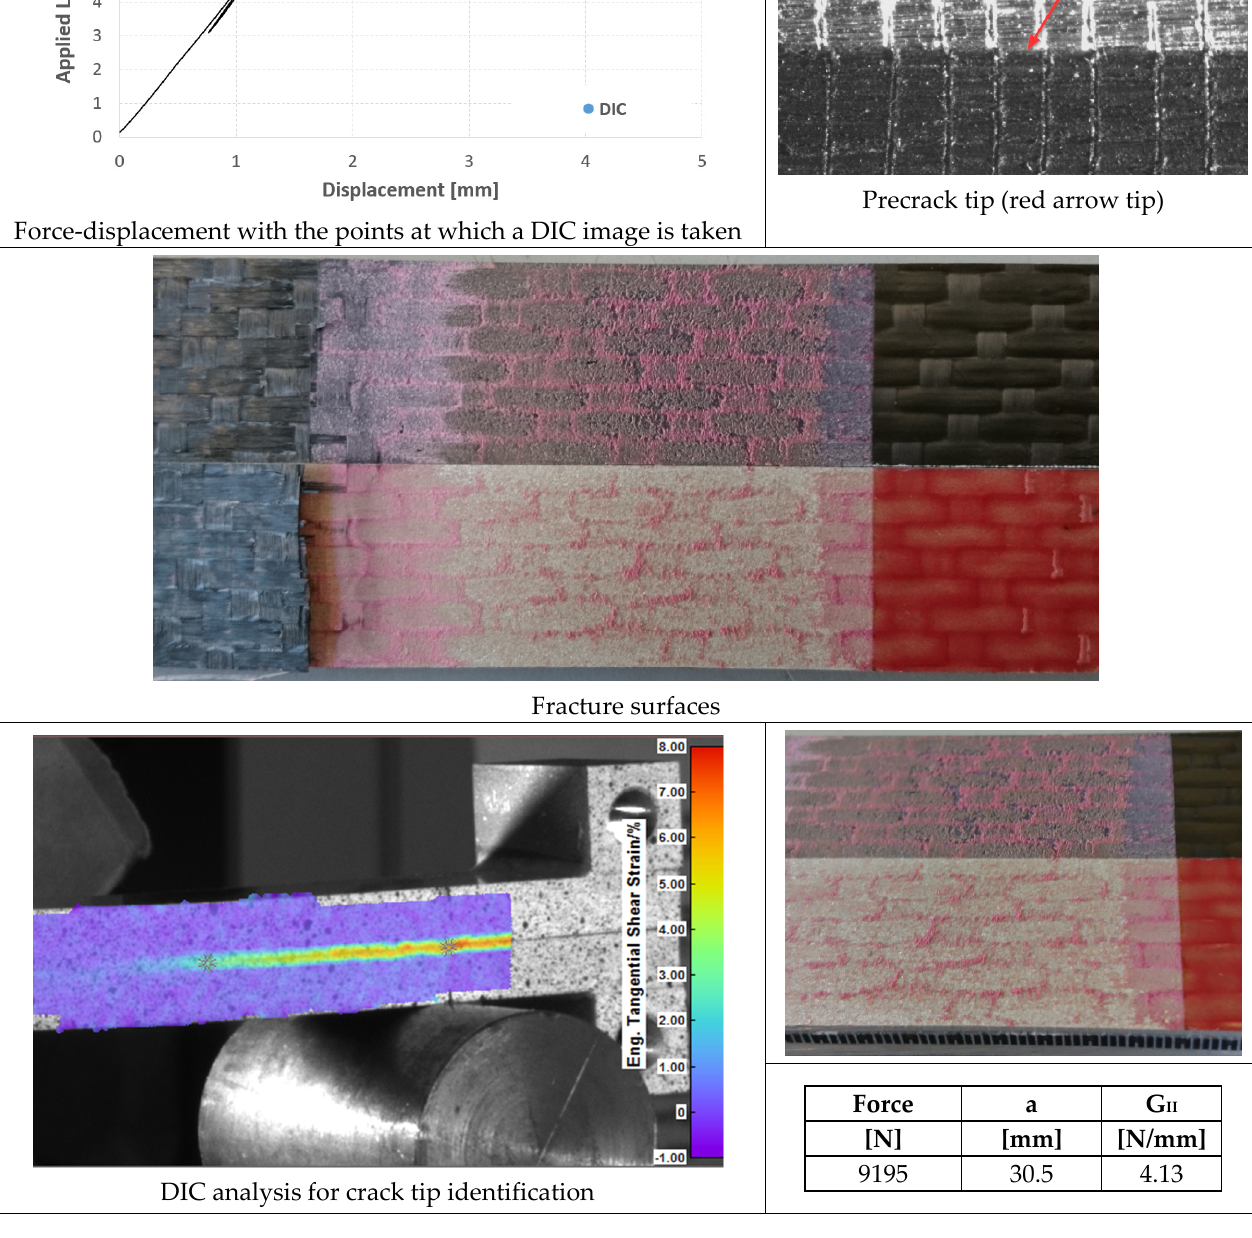
Figure 21. Results of the test on specimen ENF_AF163_02.